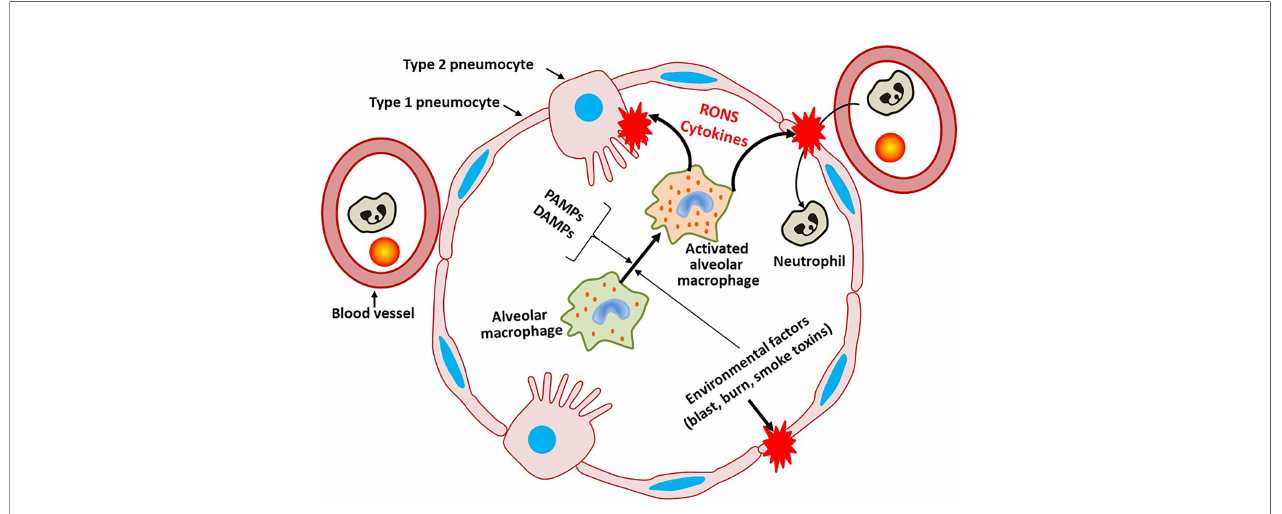
FIGURE 1 | General mechanisms damaging pulmonary barrier. Infection via pathogen-associated molecular pattern (PAMPs) or damage-associated molecular pattern (DAMPs), the latter released due to physical damage of pneumocytes, activates alveolar macrophages (AMs) and later other immune cells migrating into alveoli. Excessive activation of AMs leads to the development of lung injury due to excessive generation of reactive oxygen and/or nitrogen species (RONS), cytokine storm and pro-coagulant